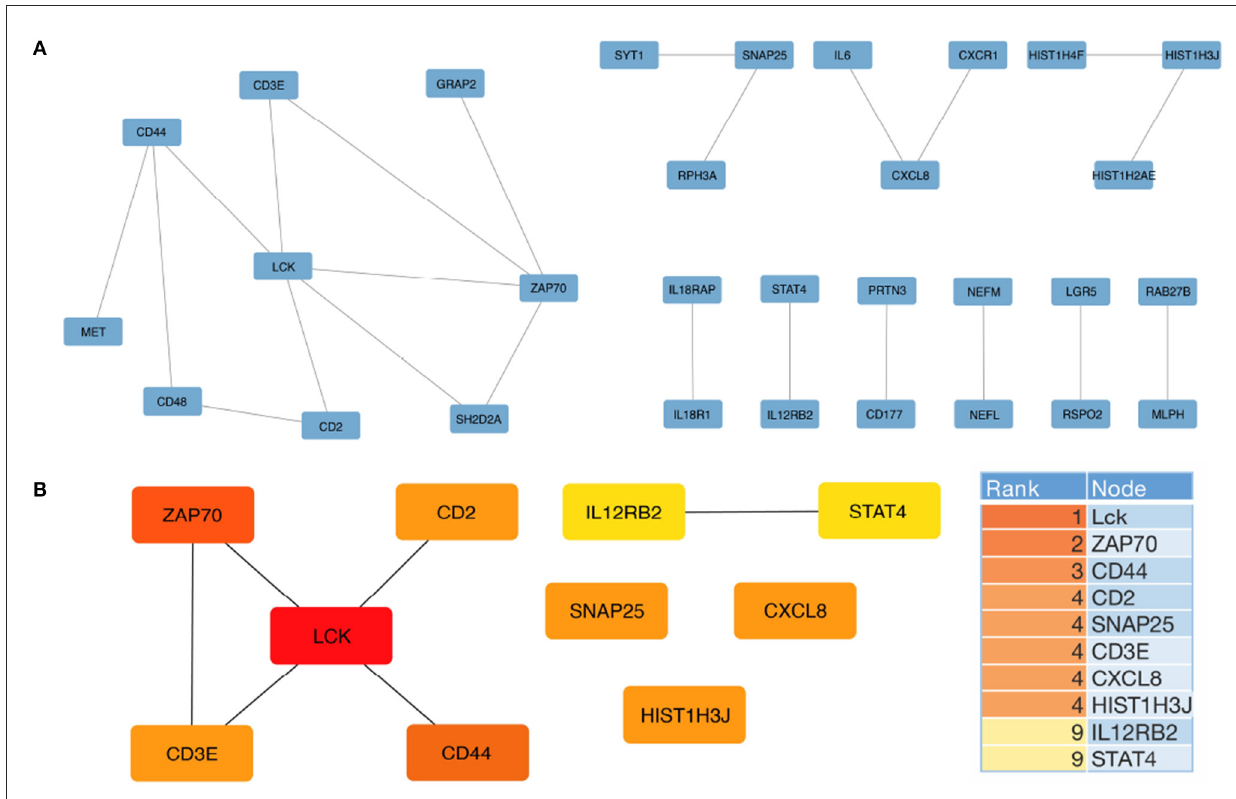
FIGURE3 Protein-protein interaction (PPI) network for DEGs and hub gene identification was constructed using STRING and Cytoscape, respectively. (A) The PPI network of all DEGs was constructed using the STRING database with the minimum required interaction score set at 0.99. (B) The top 10 hub genes were analyzed using the CytoHubba plugin. The descending color from dark orange to yellow represents decreasing interaction intensity between genes.